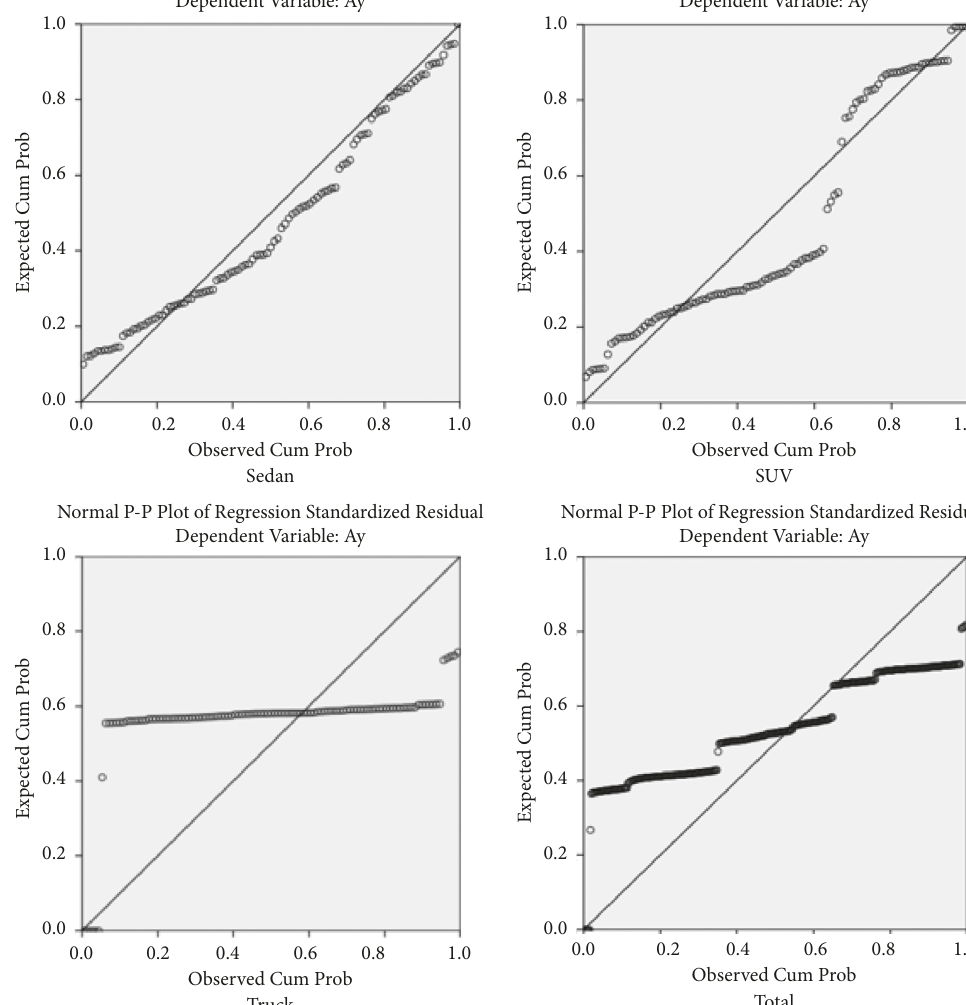
Figure 5: Correlation of the lateral acceleration model for different